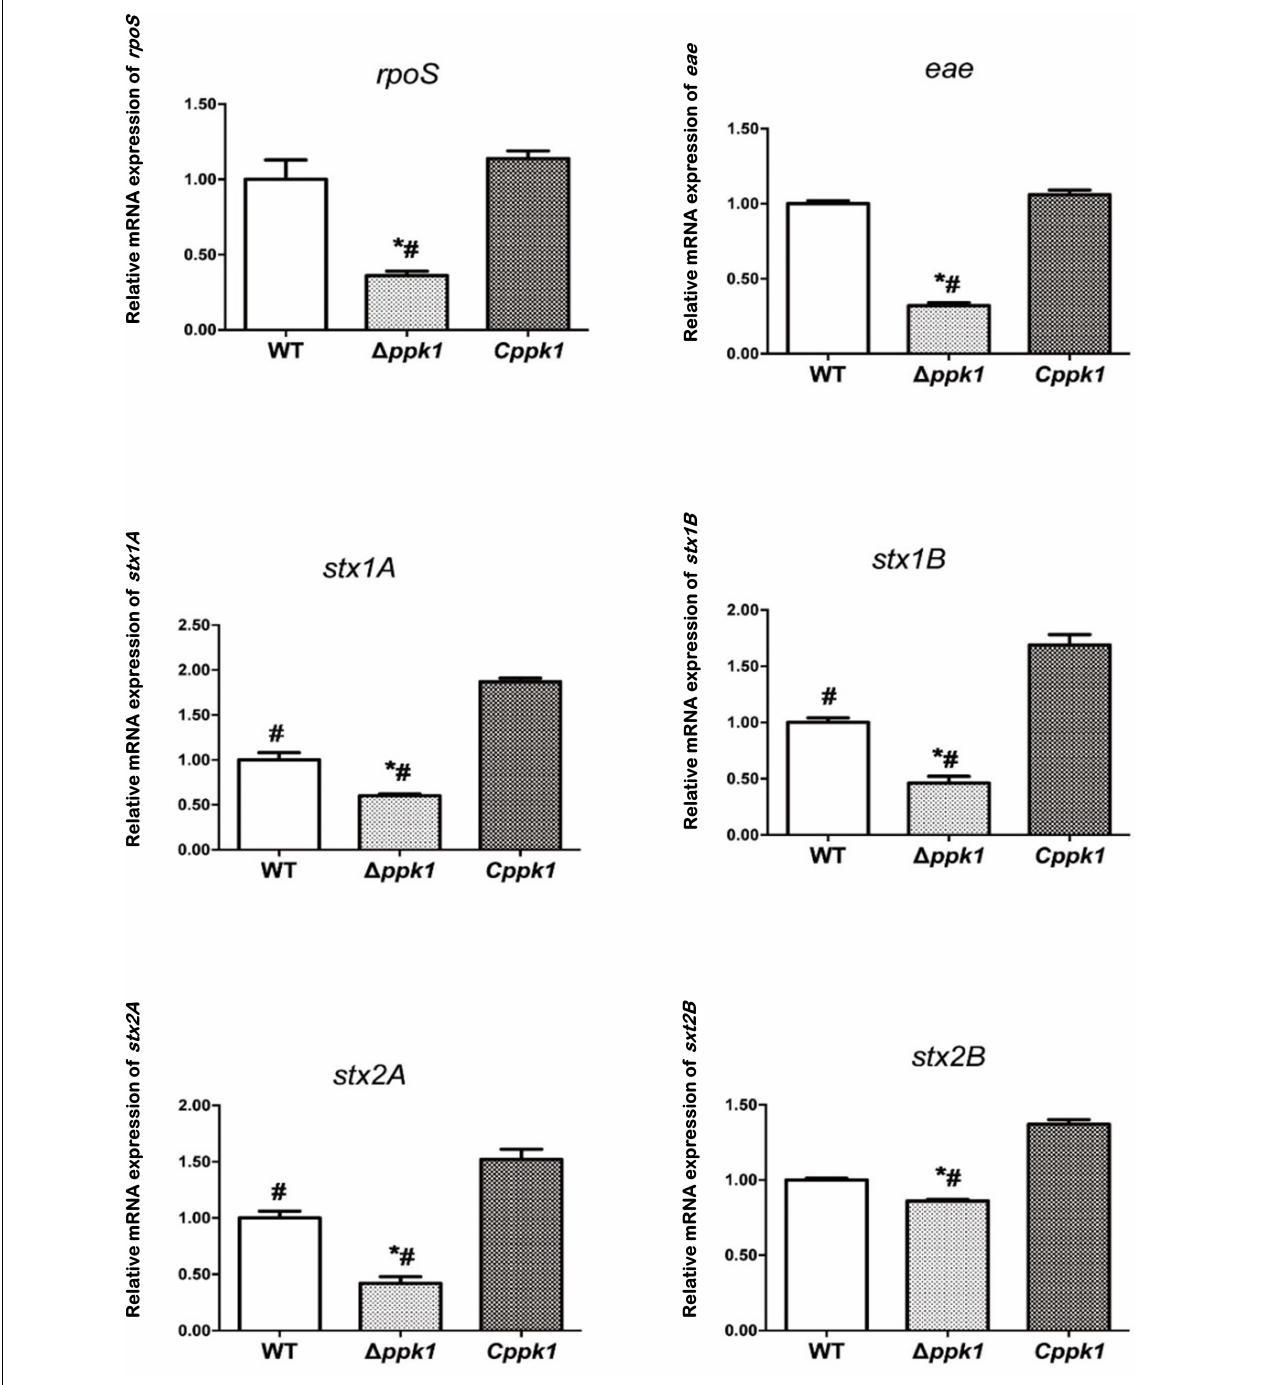
FIGURE 5 | The ppk1 gene regulated the mRNA expression of rpoS , eae , stx1A , stx1B , stx2A , and stx2B . The relative mRNA expression of rpoS , eae , stx1A , stx1B , stx2A , and stx2B of WT, ppk1 and Cppk1 were measured via real-time PCR. Data were normalized to the relative RNA expression of the 16S rRNA. *, p < 0.05 as compared with the WT strain; #, p < 0.05 as compared with the Cppk 1